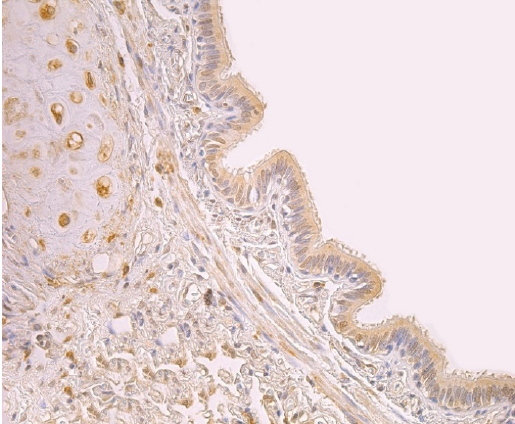
Figure 1. Note a moderate number of HBD-2 positive cells in the bronchial epithelium and cartilage of 59-year-old female bronchial wall. HBD-2 IMH, ×250.